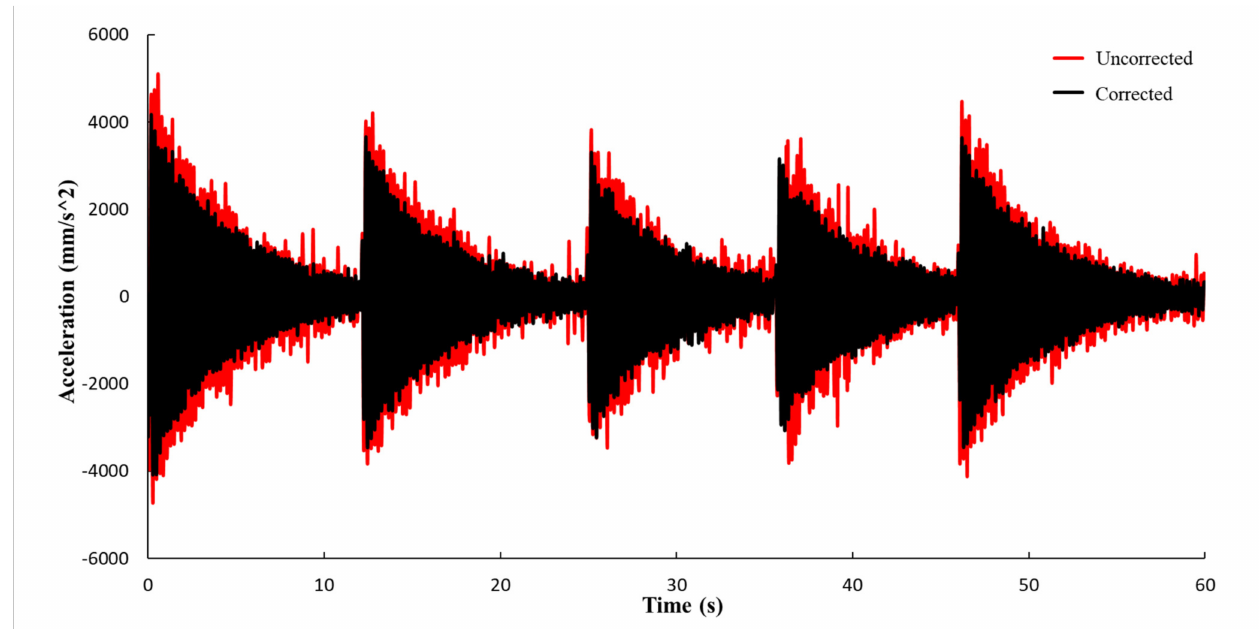
Figure 9. 2nd-differential curves of two signals (uncorrected and corrected). The results of homography transformation and differential filtering show the same free vibration attenuation characteristics by comparing the two curves in Figure 9. The curve of the differential filtering of corrected UAV signals is smoother than that of direct differential filtering of original UAV signals. Based on the above results, the feasibility of using differential filtering without geometric correction can be preliminarily